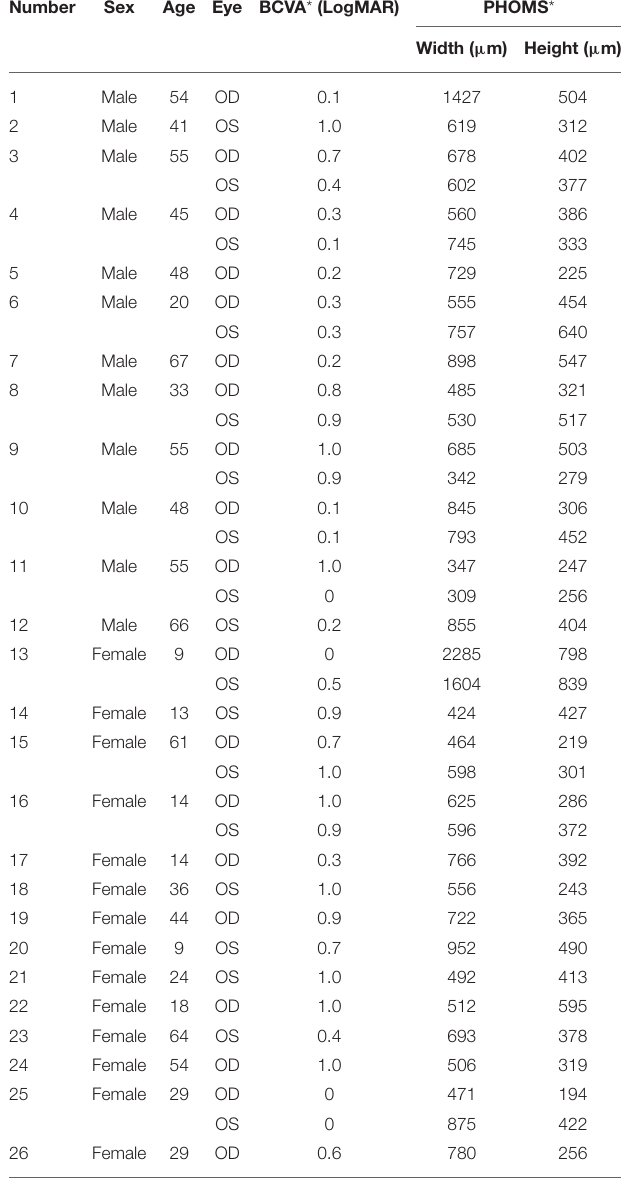
TABLE 1 | Basic patient characteristics.